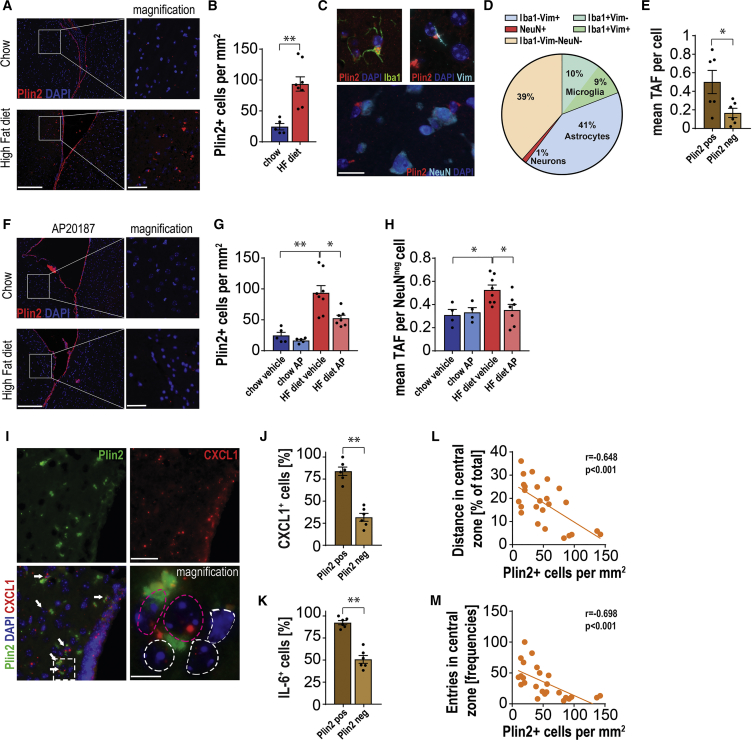
Obesity-Related Accumulation of Lipid Droplets in Senescent Periventricular Glia Is Reduced upon Senescent Cell Clearance(A) Representative images of perilipin 2 (Plin2) staining showing accumulation of cells exhibiting a buildup of lipid droplets in close proximity to the lateral ventricle (LV) of middle-aged, obese mice compared to their lean littermates. Scale bars, 200 μm/50 μm (for magn.)(B) Quantification of frequencies of Plin2+ cells in the proximity (up to 250 μm from the ependymal cell layer) to the LV in high-fat diet (HFD)-fed and lean mice (t(11) = 4.48, p = 0.0009).(C) Representative images showing Plin2+ cells co-localizing with markers of microglia (Iba1; top left panel) and astrocytes (vimentin [Vim]; top right panel), but not with neuronal markers (NeuN; bottom panel, scale bars, 20 μm).(D) Pie chart shows cell-type composition of Plin2+ cells, determined after immunostaining for Plin2 and different cell-type markers, as shown in (C).(E) Periventricular Plin2+ glial cells show increased numbers of the senescence marker, telomere-associated foci (TAF). Quantification of the mean number of TAF per cell in non-neuronal (NeuNneg) Plin+ and Plin− cells (t(10) = 2.475, p = 0.0328).(F) Representative images show the LV of chow (top panel) and HFD AP20187-treated mice stained with Plin2, exhibiting reduced lipid droplets. Scale bars, 200 μm/50 μm (for magn.)(G) Quantification of cells containing lipid droplets (Plin2+) in the periventricular area of lean HF INK-ATTAC mice with or without AP20187 treatment (t(11) = 4.48, p = 0.0009; t(9.362) = 3.28, p = 0.0091).(H) Quantification of frequencies of NeuNneg, TAF-positive cells in the periventricular region of lean/HFD and vehicle- or AP20187-treated mice (t(10) = 3.128, p = 0.0107; t(13) = 2.693, p = 0.0184).(I) Representative images showing double staining for CXCL1 (RNA-ISH in red) and Plin2 (green) in the periventricular area of HF INK-ATTAC mice. White arrows indicate CXCL1 and Plin2 double positive cells (scale bars, 50 μm/10 μm for mag.). Cells magnified in panel 4 encircled in red show positive staining for Plin2 and CXCL1, whereas white-bordered cells are not double positive.(J and K) Quantification of cells positive for (J) Cxcl1 (t(10) = 8.017, p < 0.0001) and (K) Il-6 (t(10) = 8.298, p < 0.0001) stained by RNA-ISH indicate that Plin+ cells display significantly higher expression levels of the SASP factors, Il-6 and Cxcl1, than Plin− cells.(L and M) Buildup of fat in periventricular brain region as assessed by Plin2 staining significantly correlates with parameters associated with anxiety-like behavior: (L) percentage of distance traveled in the central zone (percentage of central zone) (r = −0.6475, p = 0.0005) and (M) number of entries into the central zone (entries) in OF testing (r = −0.6976, p = 0.0001).Data are from n = 5–8 mice per group for (B), n = 6 mice per group for (E), (J), and (K), n = 4–8 mice per group for (G) and (H), and n = 25 mice per group for (L) and (M). Mean ± SEM plotted. ∗p ≤ 0.05 and ∗∗p ≤ 0.001.